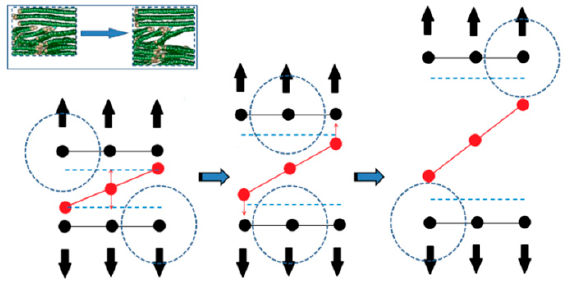
Figure 9. The typical failure mode of the C f /PyC interphase under a normal tensile load.